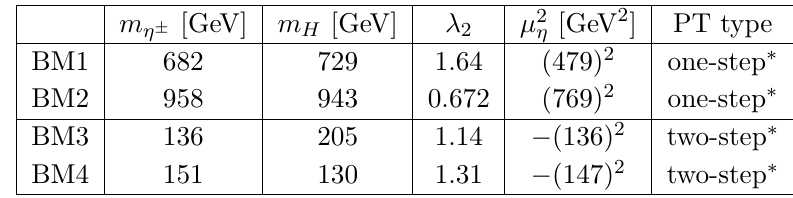
Table 2 . Benchmark parameters leading first-order PTs where the inert scalar masses m and m A represent the values at zero temperature ( m